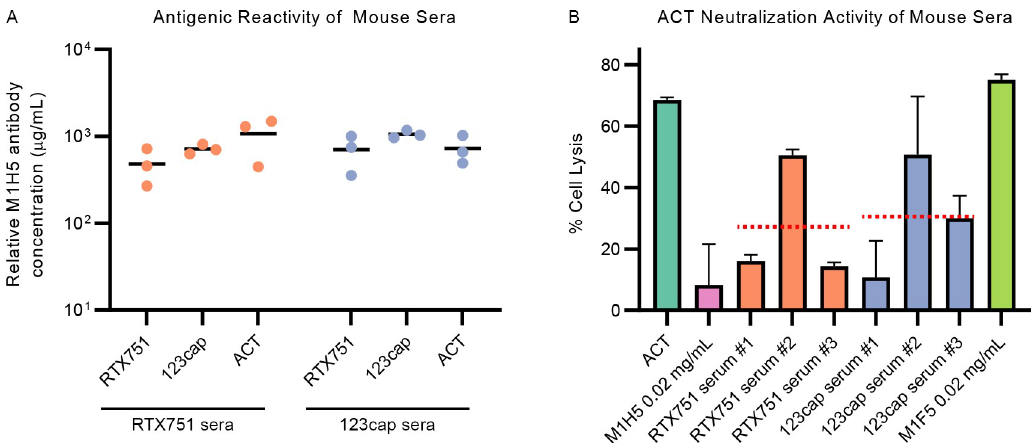
Fig 6. RTX751 and 123cap elicit similar neutralizing antibody responses. (A) Mouse serum titers against RTX751, 123cap and ACT after immunizing and boosting with either RTX751 or 123cap and Freund’s adjuvant. Each data point represents one mouse, with titers measured by ELISA using the murine M1H5 antibody as a standard. The x-axis tick labels define the antigen of reactivity. (B) Toxin neutralization assay with 0.5 ug/mL ACT added to J774A.1 cells in the presence of a 30-fold molar excess of a neutralizing anti-ACT antibody (M1H5), non-neutralizing anti-ACT antibody (M1F5) or immune sera against 123cap or RTX751 (1:250 dilution, previously determined to be in the dose-response range; individual mice labeled #1, #2, #3). Each bar represents the mean of 2 independent assays, with error bars representing the standard error of the mean, and with each assay containing 3 technical replicates. The mean cell lysis value for sera resulting from RTX751 and 123cap immunization are shown as dashed red